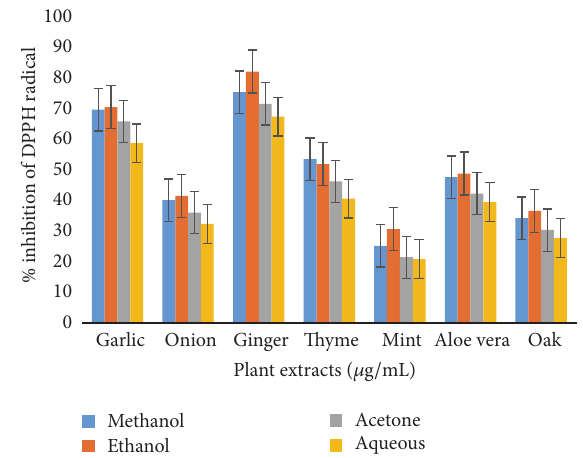
Figure 3: DPPH radical scavenging activity (IC 50 ) of extracts from different medicinal